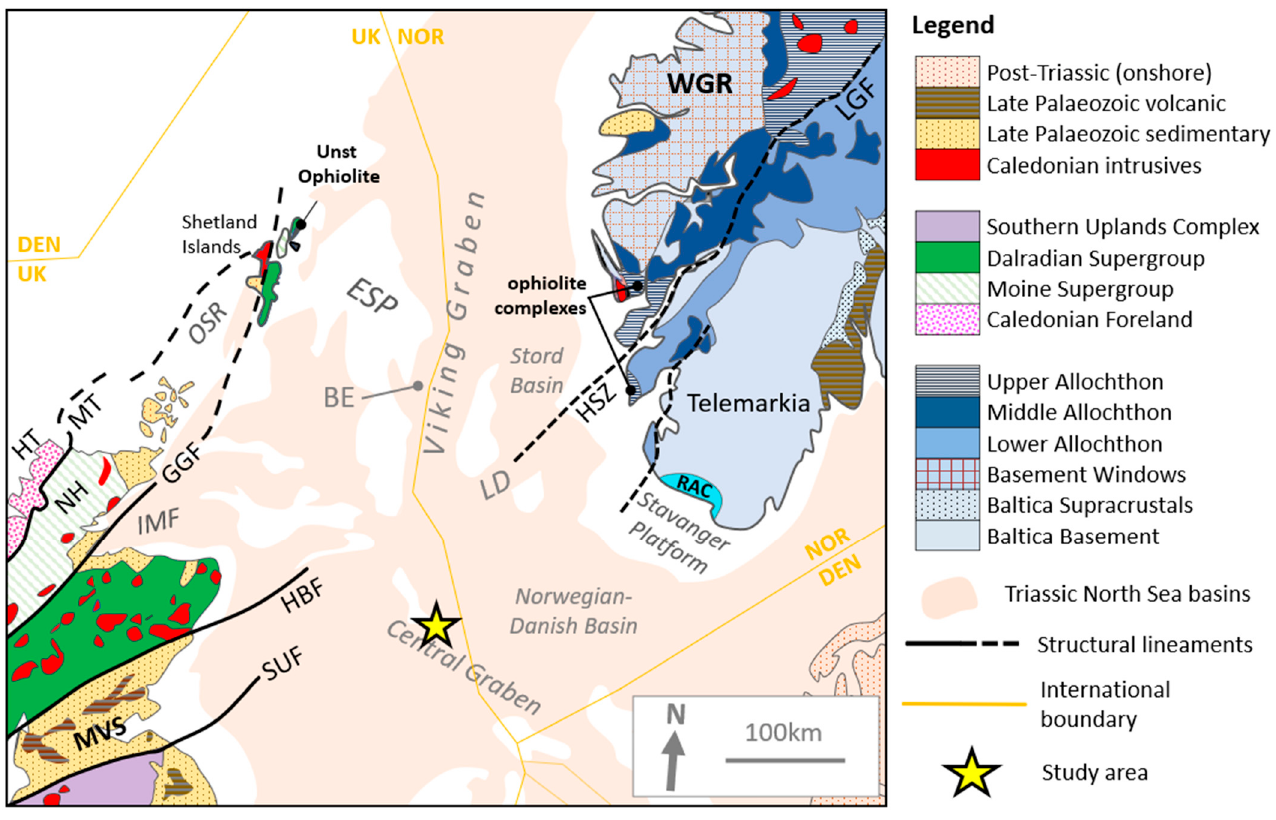
Figure 7. Geological summary map of the geological units exposed on the landmasses of Scotland and SW Scandinavia with the location of Triassic basins and structural features discussed in this paper. Abbreviations: BE, Beryl Embayment; ESP, East Shetland Platform; GGF, Great Glen Fault; HSZ, Hardangerfjord Shear Zone; HBF, Highland Boundary Fault; HT, Hebridean Terrane; IMF, Inner Moray Firth; LD, Ling Depression; LGF, Lærdal–Gjende Fault Complex; MT, Moine Thrust; MVS, Midland Valley of Scotland; NH, Northern Highland Terrane; OSR, Orkney-Shetland Ridge; RAC, Rogaland Anorthosite Complex; SUF, Southern Uplands Fault; WGR, Western Gneiss Region. Based on Corfu and Andersen [140], Goldsmith et al. [33], and Holdsworth et al. [97].